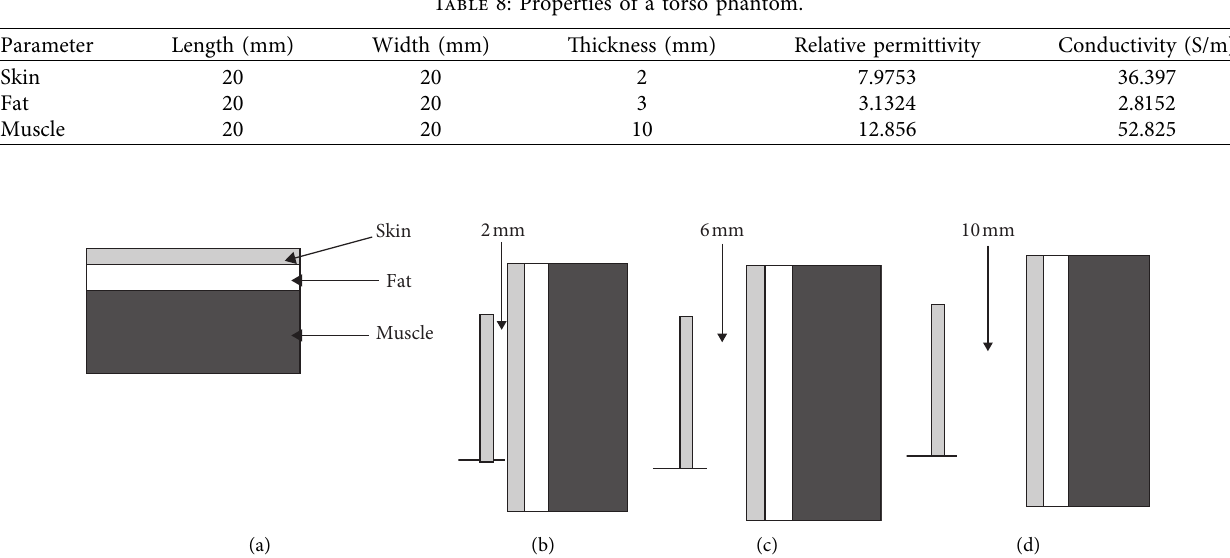
Figure 11: (a) Different layers of torso-equivalent torso, (b) antenna 2mm away from phantom, (c) antenna 6mm away from phantom and (d) antenna 10mm away from the phantom.